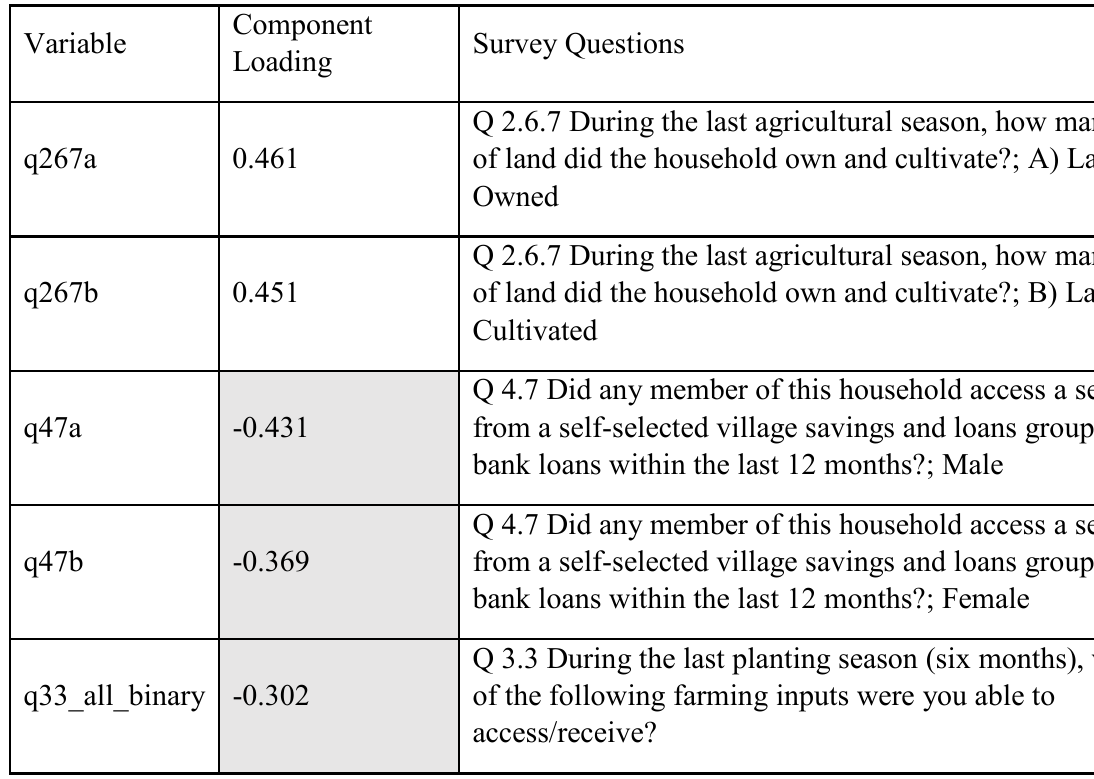
Table 1.52: Variables defining Transformative Resilience